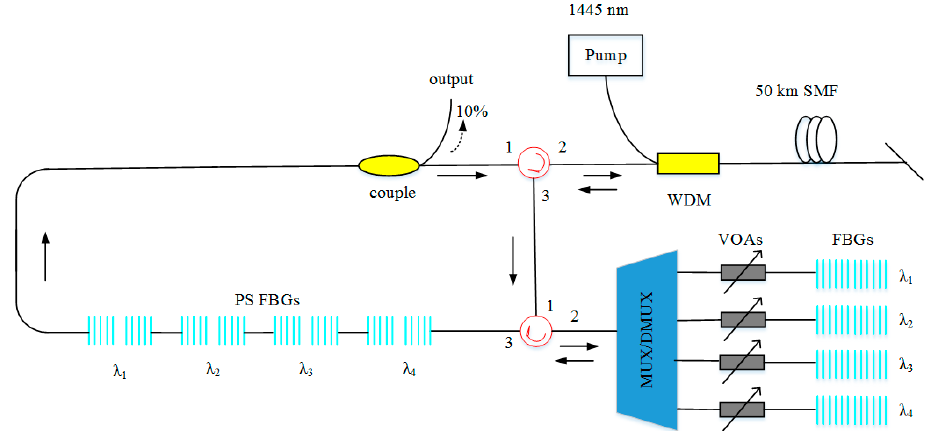
Figure 15. Setup of the multi-wavelength RFL. PS FBGs, phase-shifted fiber Bragg gratings; VOA, variable optical attenuators; MUX/DMUX, multiplexer/demultiplexer.